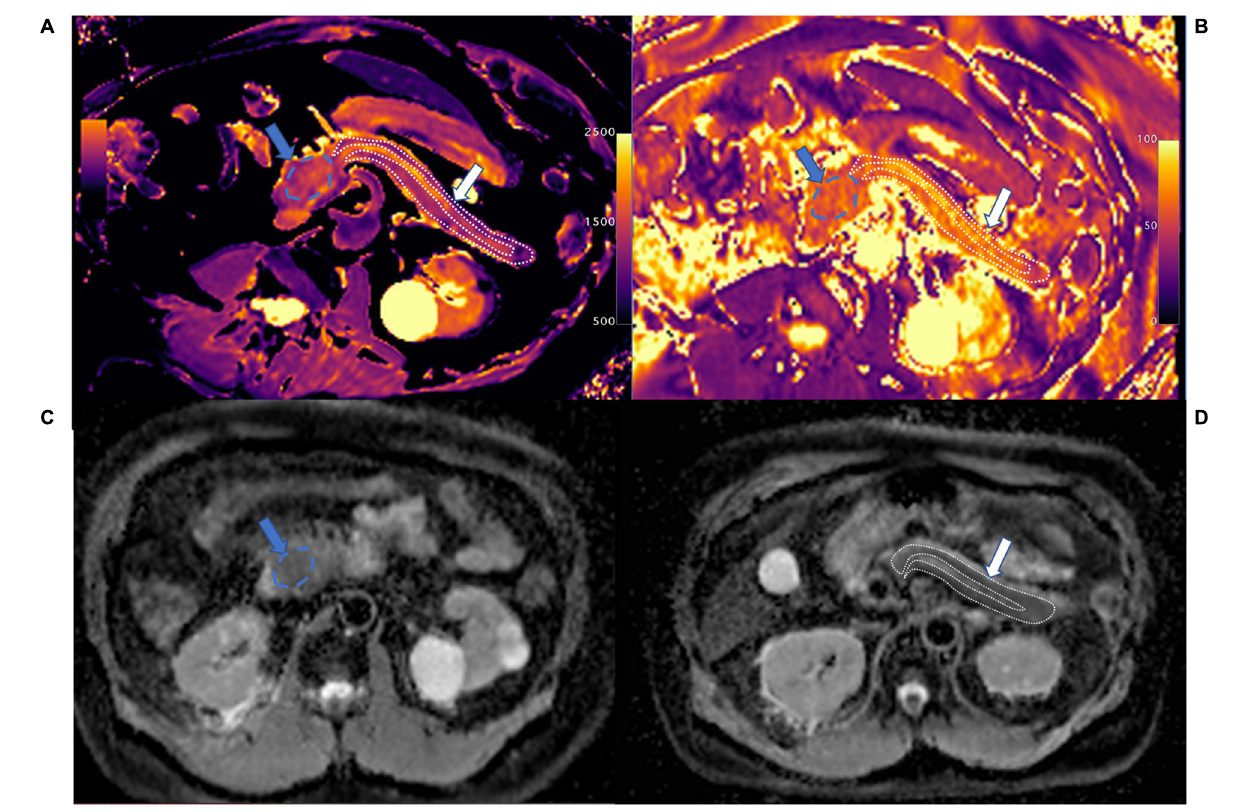
FIGURE 1 | T1 mapping (A) , T2 mapping (B) , and apparent diffusion coefficient (ADC) maps (C,D) of pancreatic ductal adenocarcinoma (PDAC; blue arrow and area) and upstream pancreas (white arrow and area). PDAC shows higher T1 (1,646.7 ± 96.1 ms) and T2 (65.1 ± 9.4 ms) values compared with upstream pancreas, and slightly higher ADC values (1.326 ± 0.098 mm 2 /s) compared with upstream pancreas on ADC maps. Upstream pancreas shows homogeneous lower T1 (1,405.2 ± 149.9 ms), iso-T2 (61.5 ± 9.2 ms), and lower ADC values (1.095 ± 0.261 mm 2 /s). The MPD shows marked dilation and high T1 and ADC values.